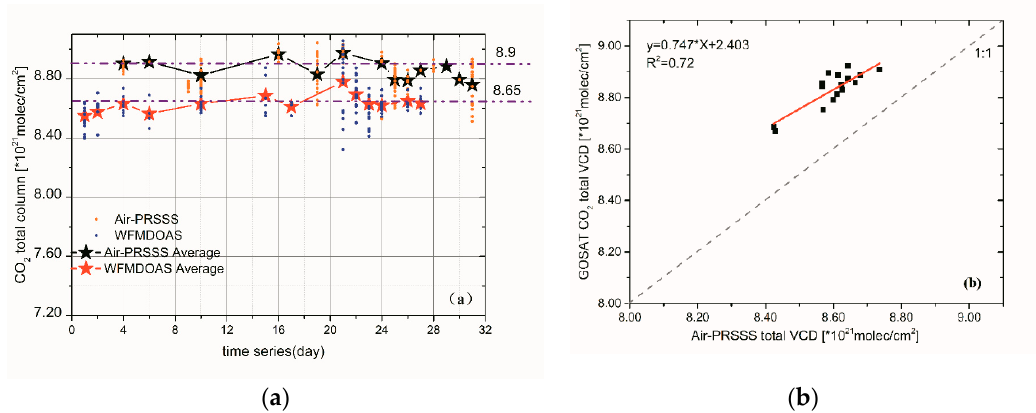
Figure 10. ( a ) Time series of CO 2 columns measured by the Air-IRSS and GOSAT. The GOSAT data are selected within 5° latitude and longitude box around Hefei site (black dots) and the Air-IRSS data are selected within 30 min of the GOSAT overpass time (red dots). ( b ) Correlation plot between coincident CO 2 columns obtained by the Air-IRSS and GOSAT. Only measurements that fulfill the coincidence criteria are included. The red solid line is the linear fitted curve of the scatter points. The gray dashed line denotes one-to-one line.